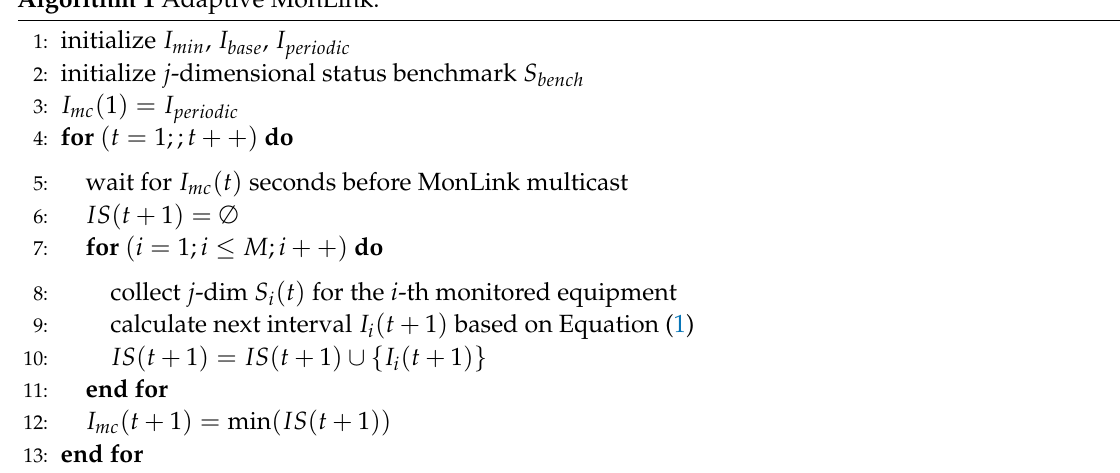
Algorithm 1 Adaptive